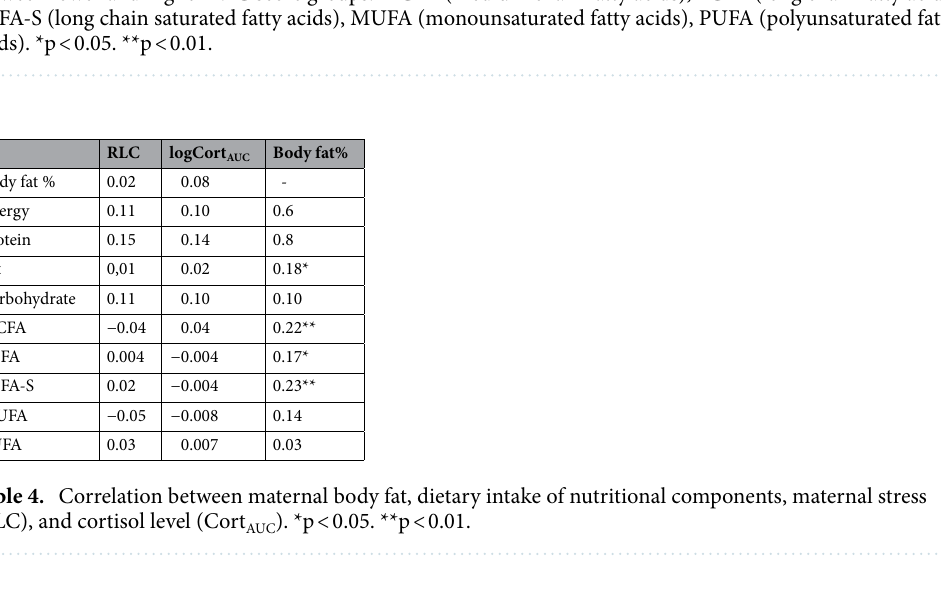
Table 3. Fatty acids of breast milk samples collected from mothers participating in the study and differences between lower and higher RLC score groups. MCFA (medium chain fatty acids), LCFA (long chain fatty acids),